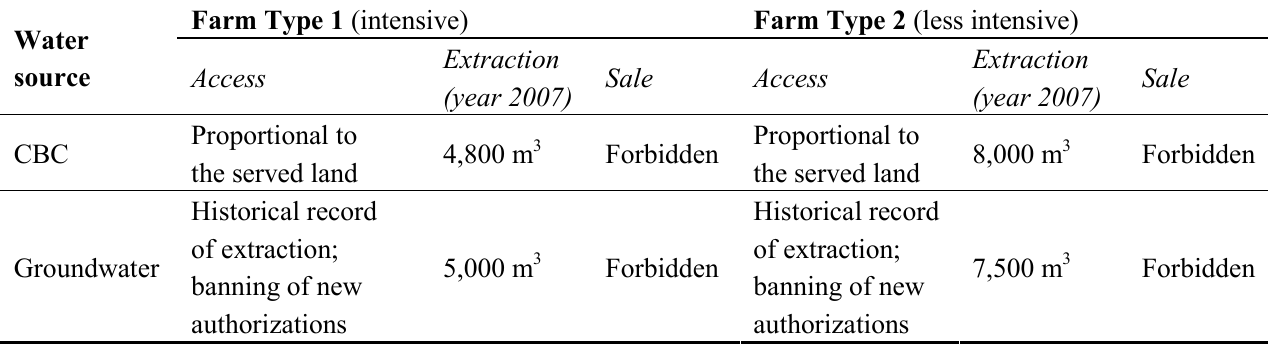
Table 2. Current situation of groundwater use rights in the study area.